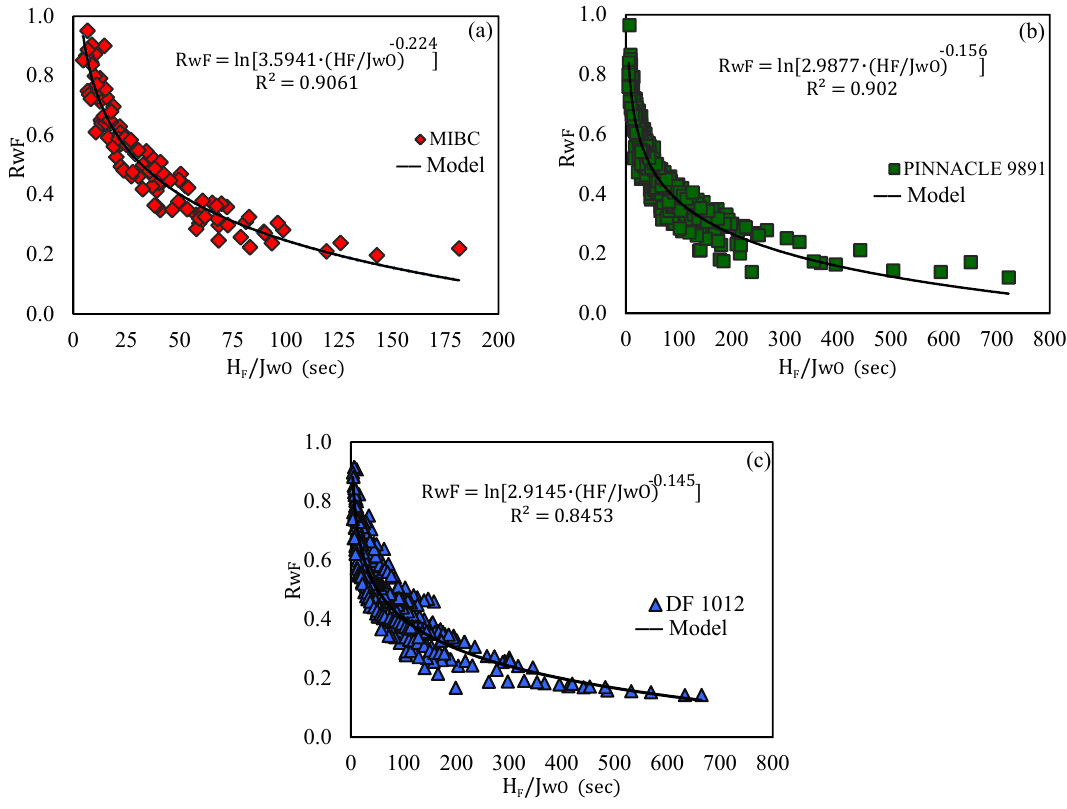
Figure 7. Froth water recovery as a function of the average liquid retention time in the froth (H F /J wO ) for ( a ) MIBC, ( b ) PINNACLE 9891, ( c ) DF 1012.